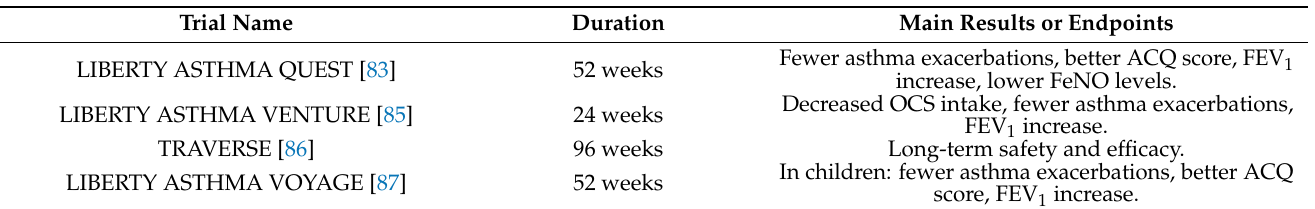
Table 2. Dupilumab: summary of the main studies carried out in asthmatic